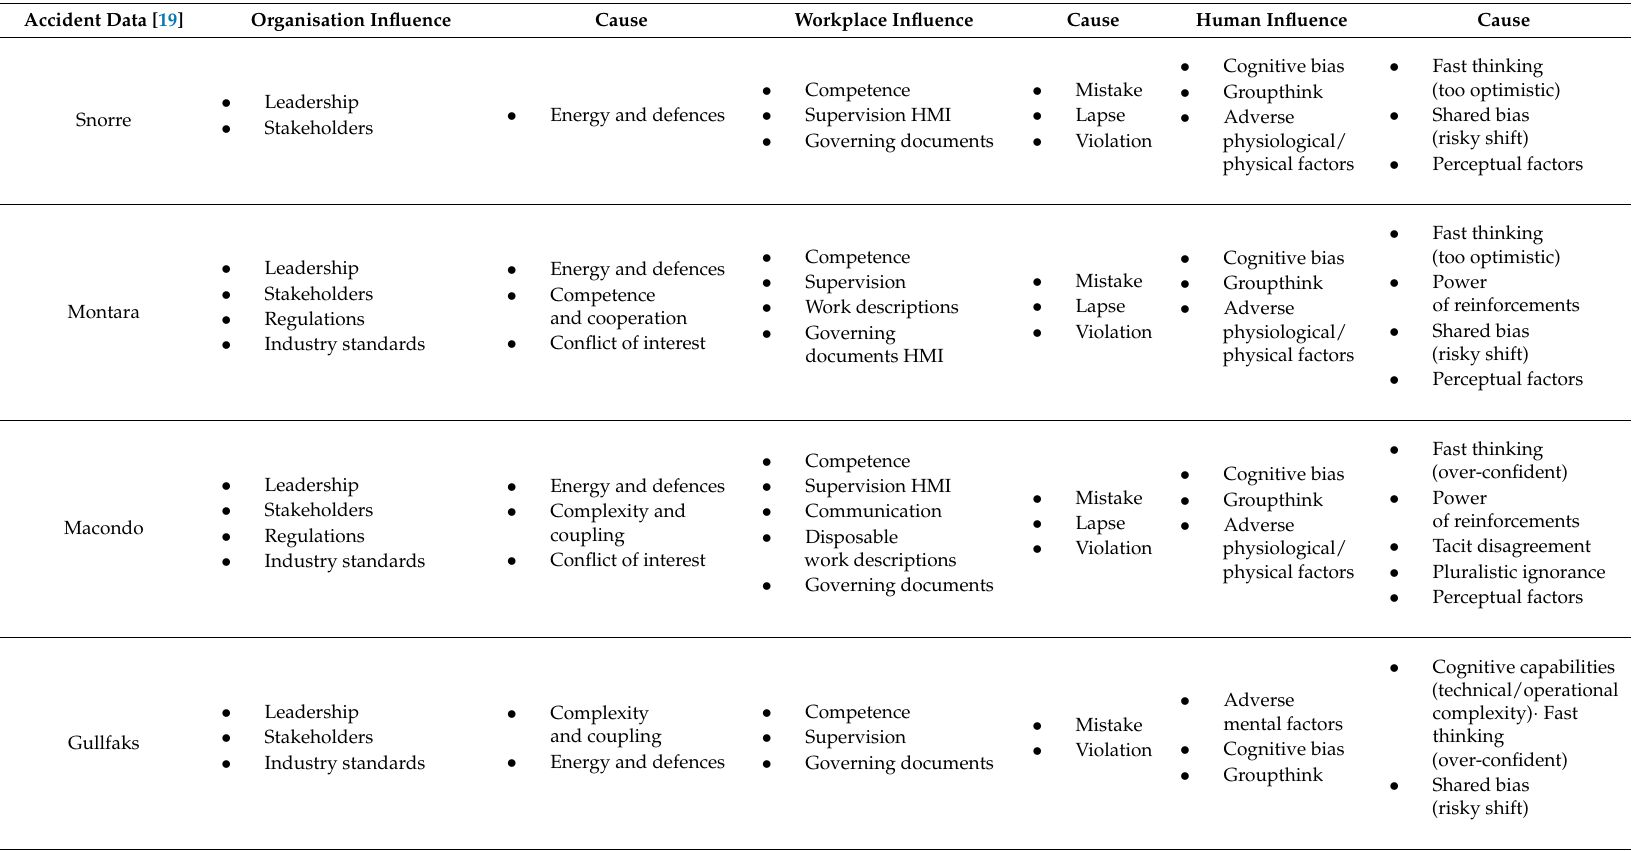
Table 3. Well accident data causal classifications made in validation of task